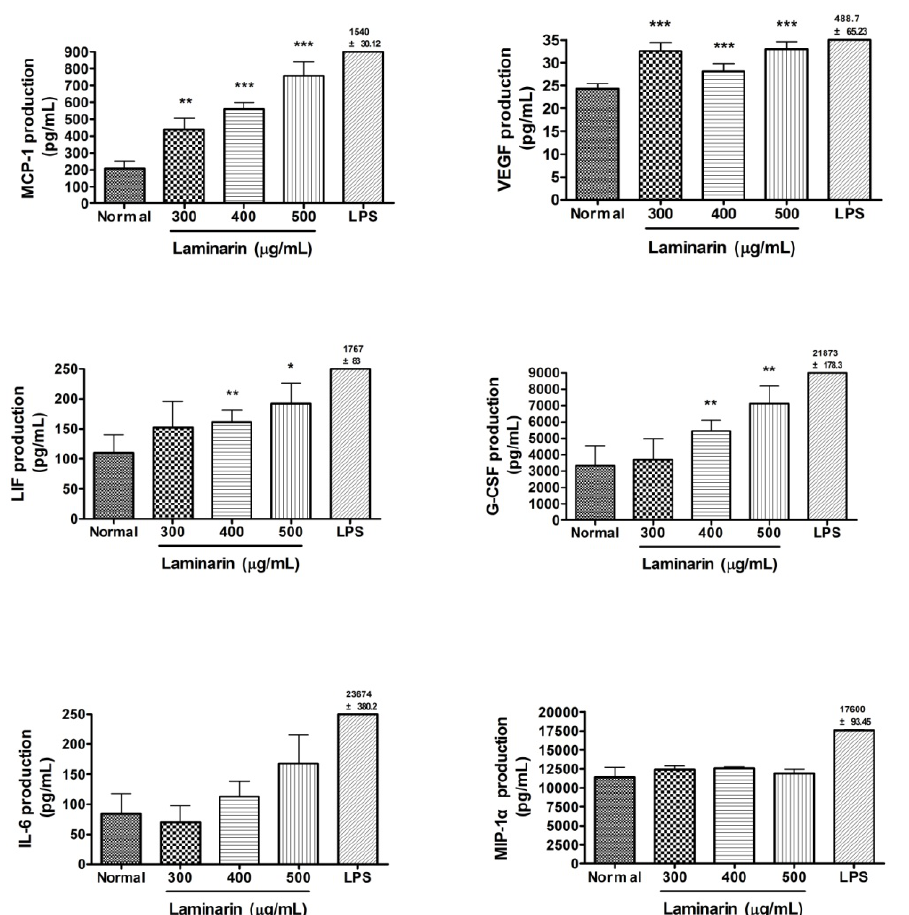
Figure 4. Effects of laminarin on cytokine production (MCP-1, VEGF, LIF, G-CSF, IL-6, and MIP-1 α ) in RAW 264.7 mouse macrophages. After 24 h incubation with laminarin, fluorescence intensity of each cytokine in the culture medium was measured by Multiplex bead-based cytokine assay. The normal group (Normal) was treated with medium only. Lipopolysaccharide (LPS; 1 µg/mL) was used as a positive control. Values are the mean